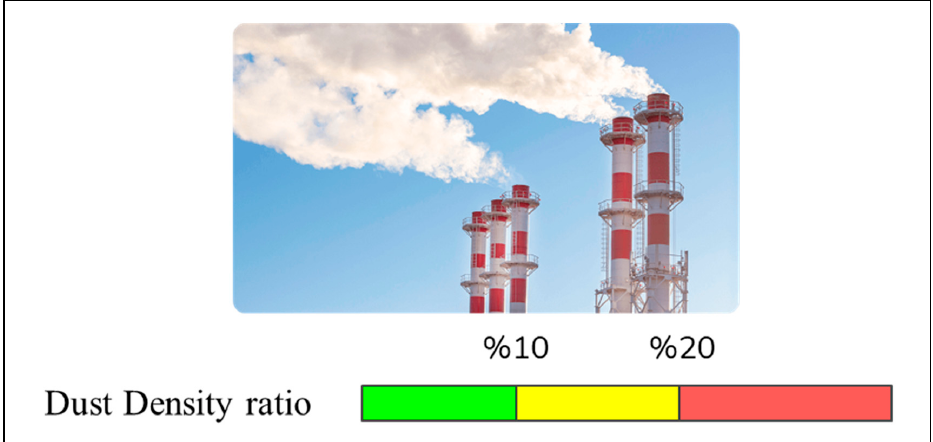
Figure 5. The visual representation of the optimum dust density ratio ranges of the product line environment. line environment.